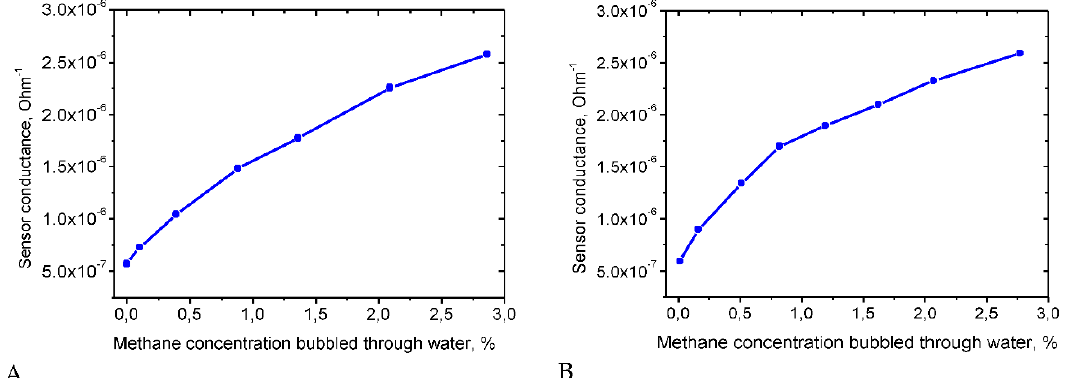
Figure 6. Sensorconductivity as a function of methane concentration in air bubbled through water:( A ) Ceramic membrane with pore size of 100 nm; ( B ) Ceramic membrane with pore size of 10 μ